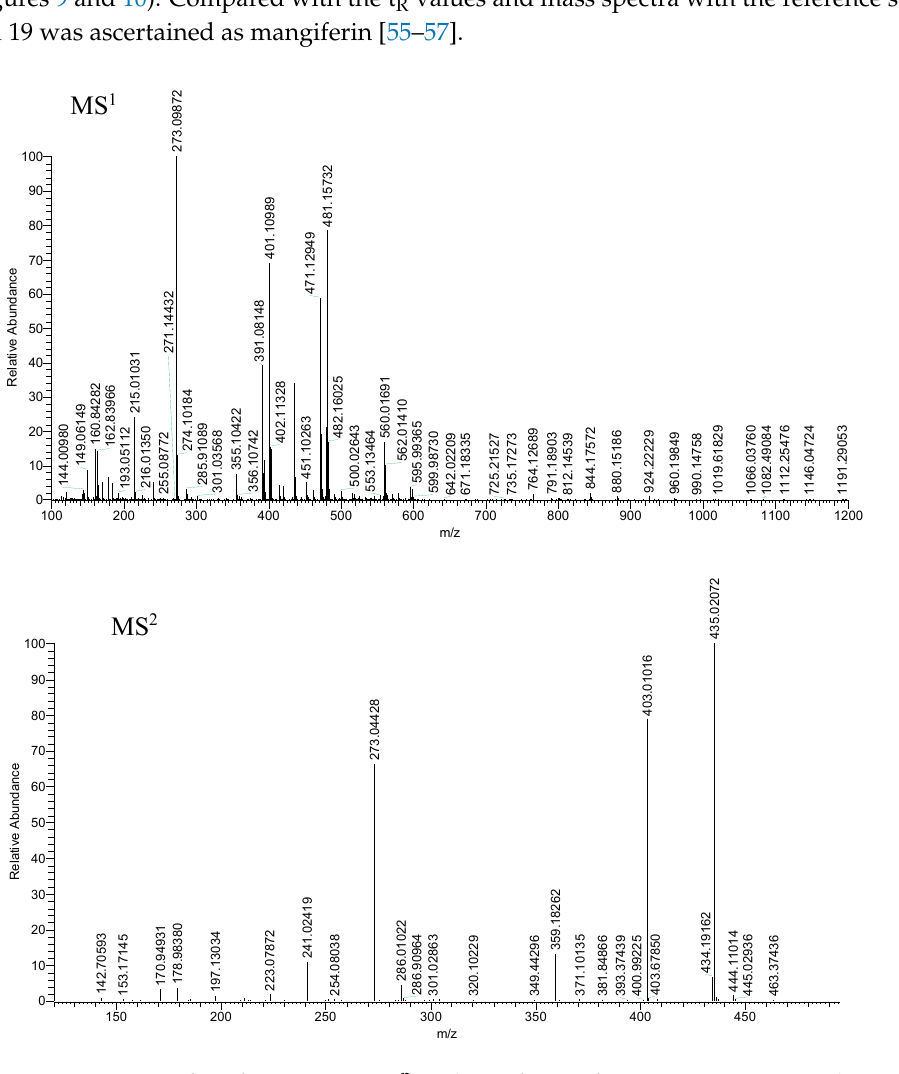
Figure 9. Spectra of ion fragments in MS n analysis of mangiferin in negative ion modea.